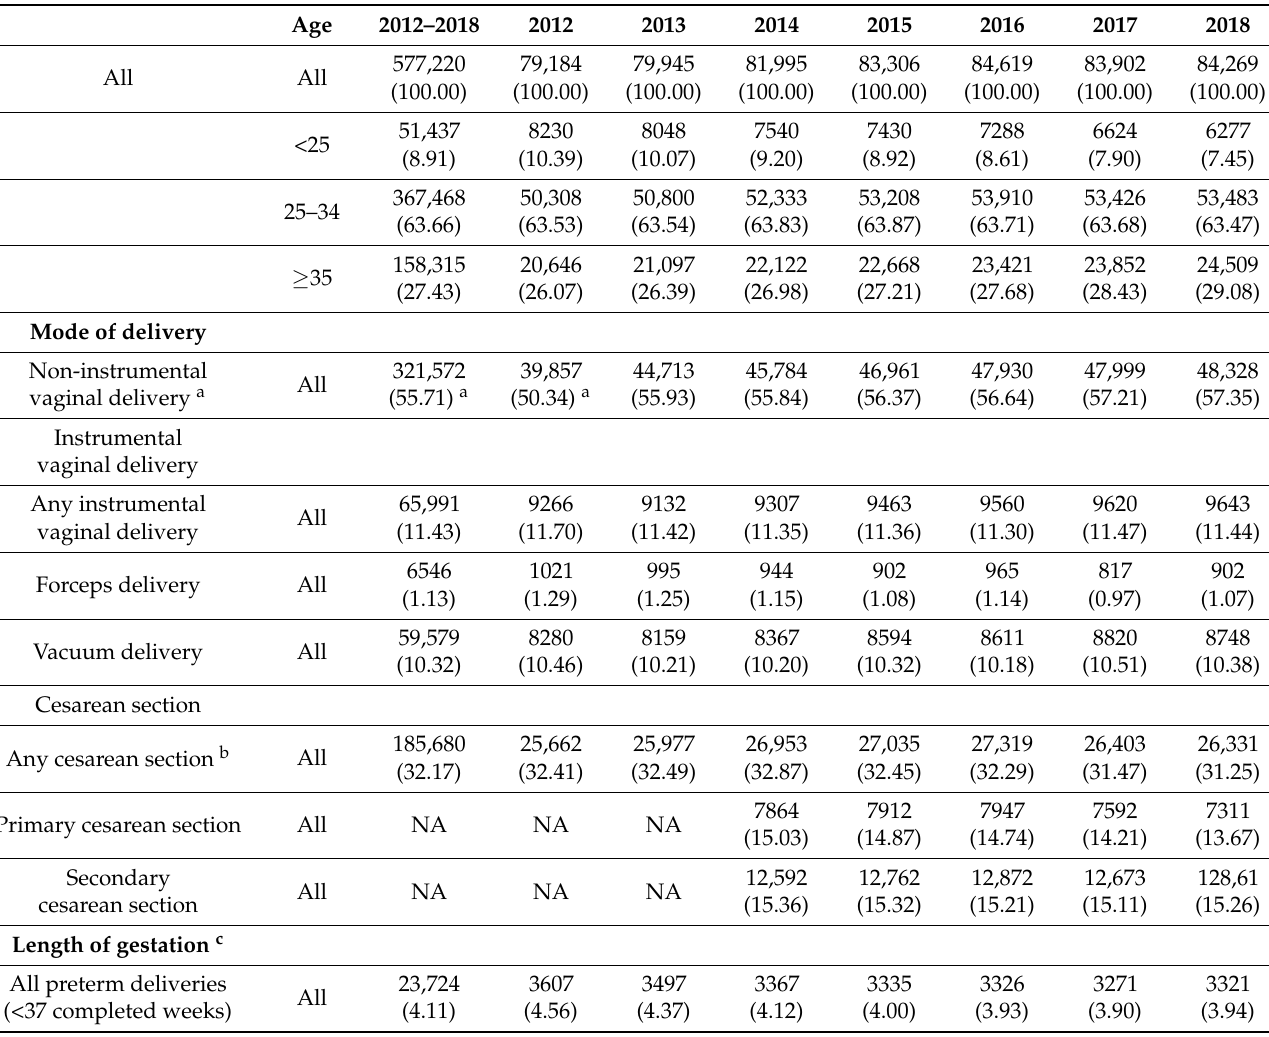
Table 3. Prevalence of mode of delivery, length of gestation, and other recorded adverse maternal obstetric outcomes during the delivery hospitalization in the MS dataset. All variables by maternal age category are shown in Table